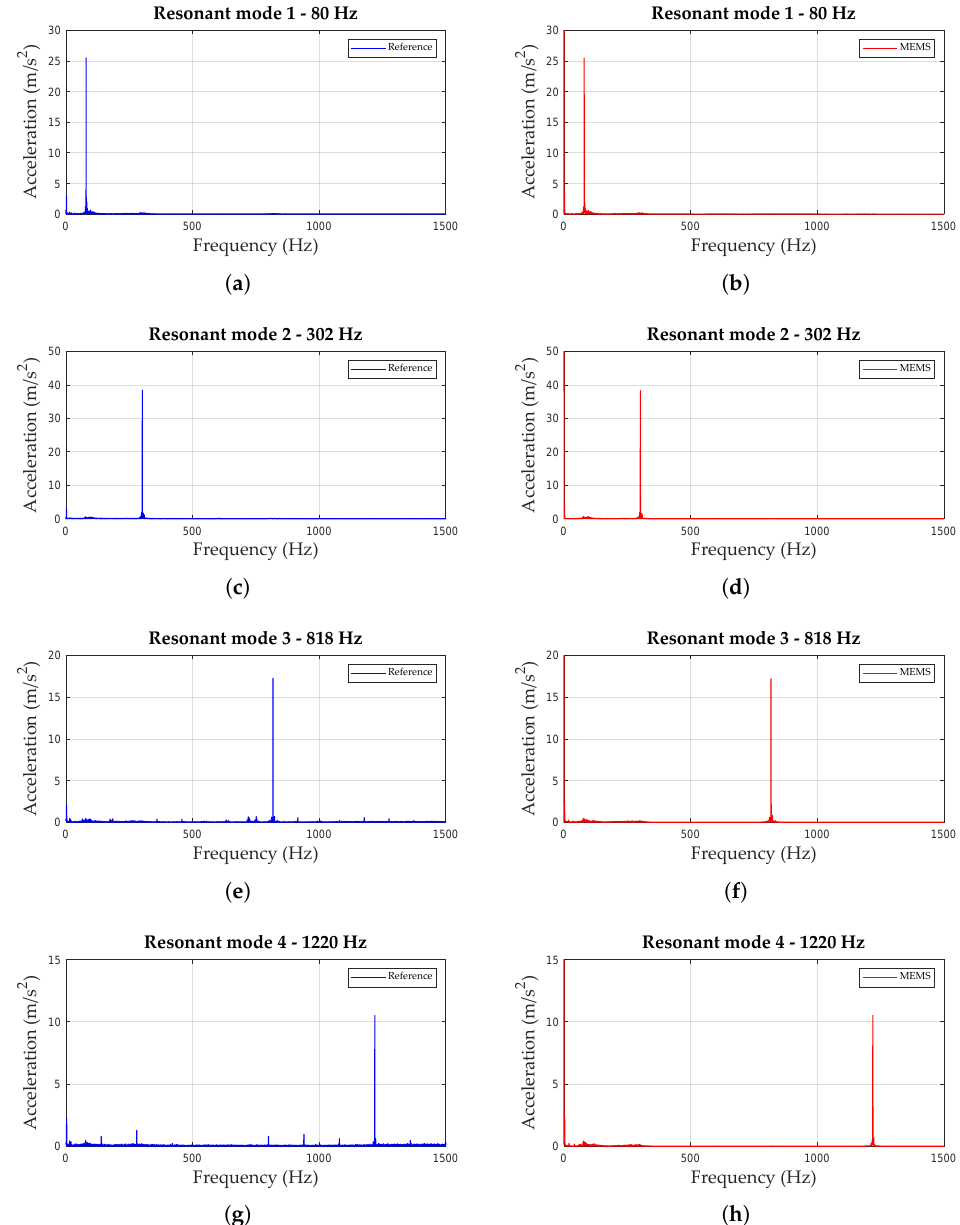
Figure 4. FFT of the reference and MEMS accelerometer signals at a rotor speed of 180 rpm consider- ing: ( a , b ) the first resonant mode, ( c , d ) the second resonant mode, ( e , f ) the third resonant mode, and ( g , h ) the fourth resonant